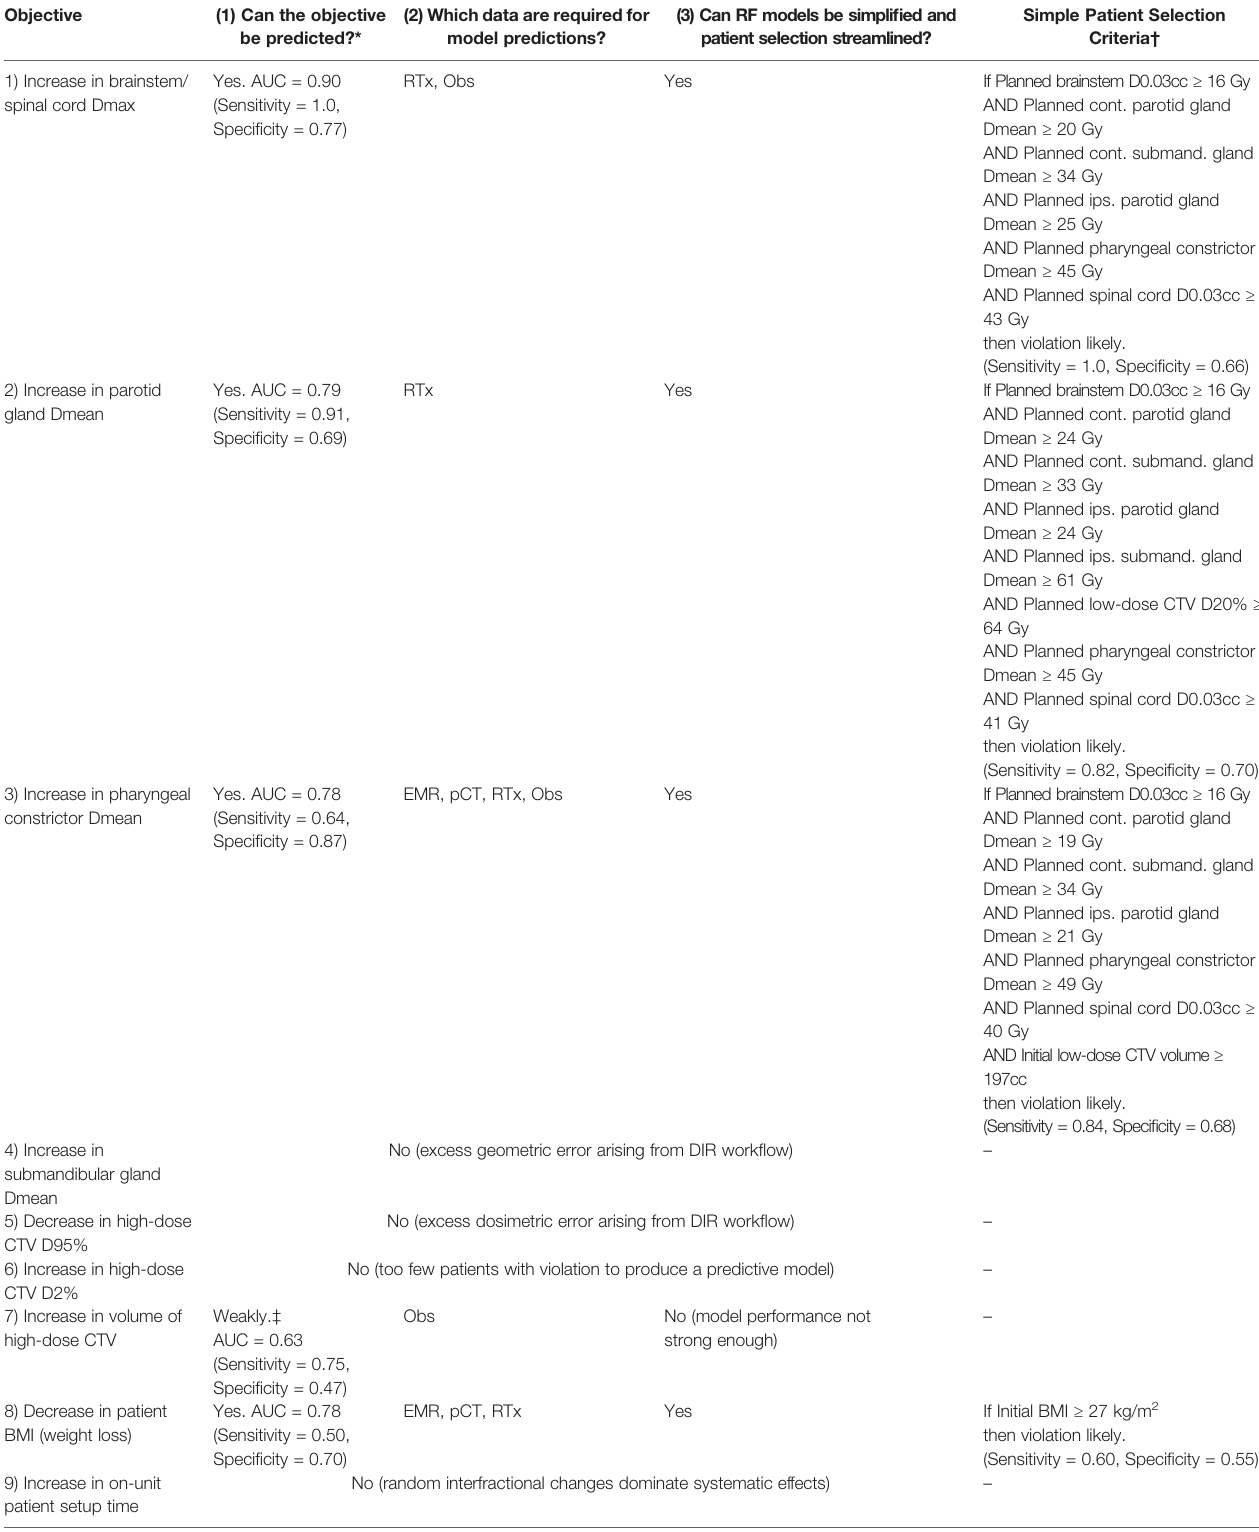
TABLE 5 | Simpli fi ed patient selection guidelines for ART based on the most predictive RF models.